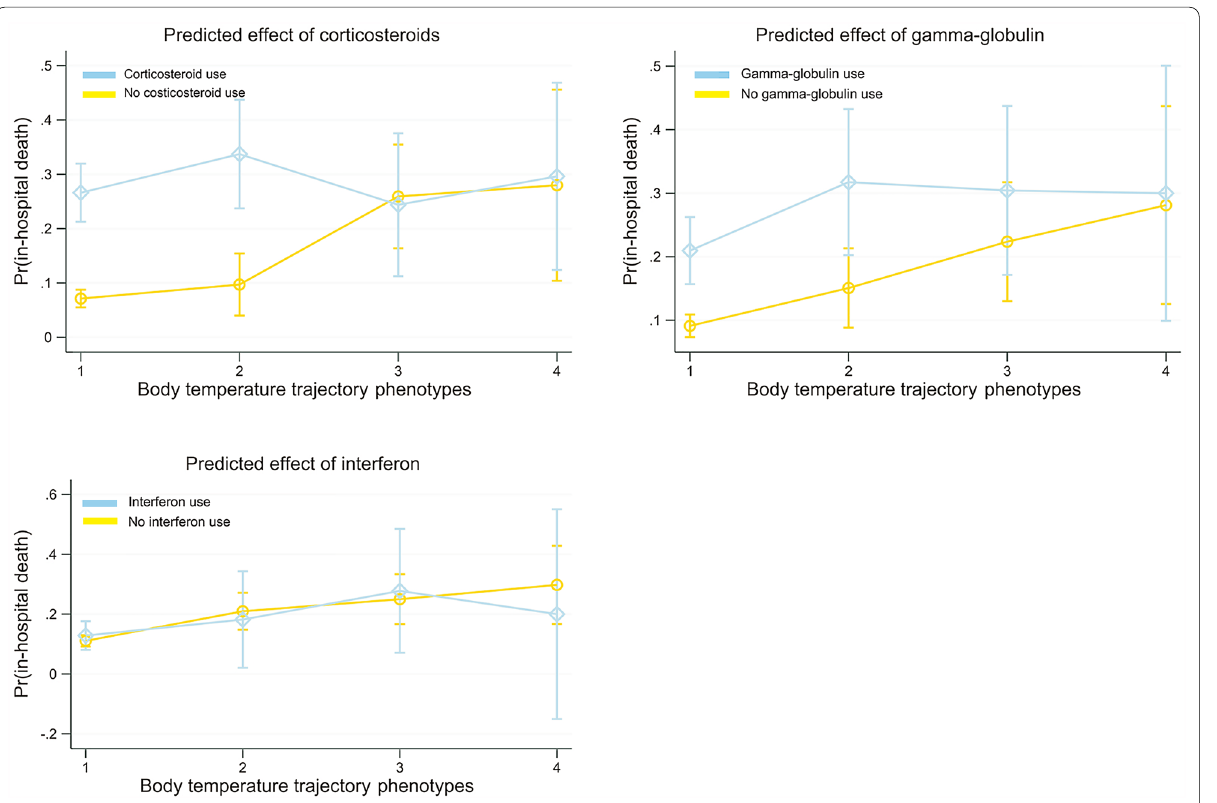
Fig. 3 The predicted marginal effect of immunotherapy in each temperature-trajectory phenotype. Corticosteroid use was associated with significantly increased in-hospital mortality in Phenotypes 1 and 2, while this association was not significant in Phenotypes 3 and 4 ( p for interaction < 0.01). A similar trend was observed for gamma-globulin; however, the difference in effect size between the four temperature-trajectory phenotypes was not significant ( p for interaction > 0.05). The effectiveness of interferon therapy was consistent for all four